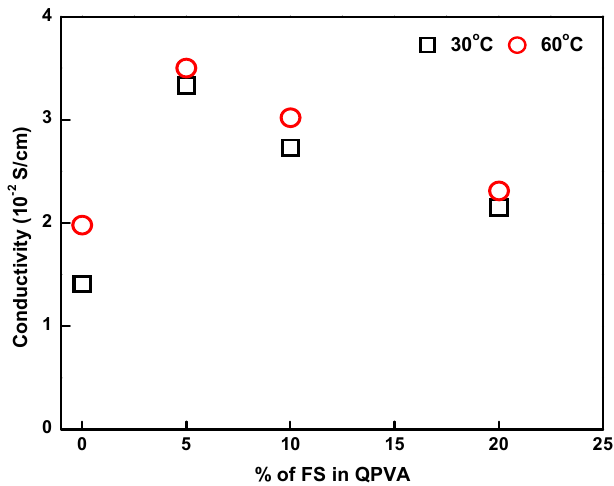
Figure 8. Ionic conductivity of pristine QPVA and QPVA membranes with different percentages of fumed silica at 30 and 60 °C.